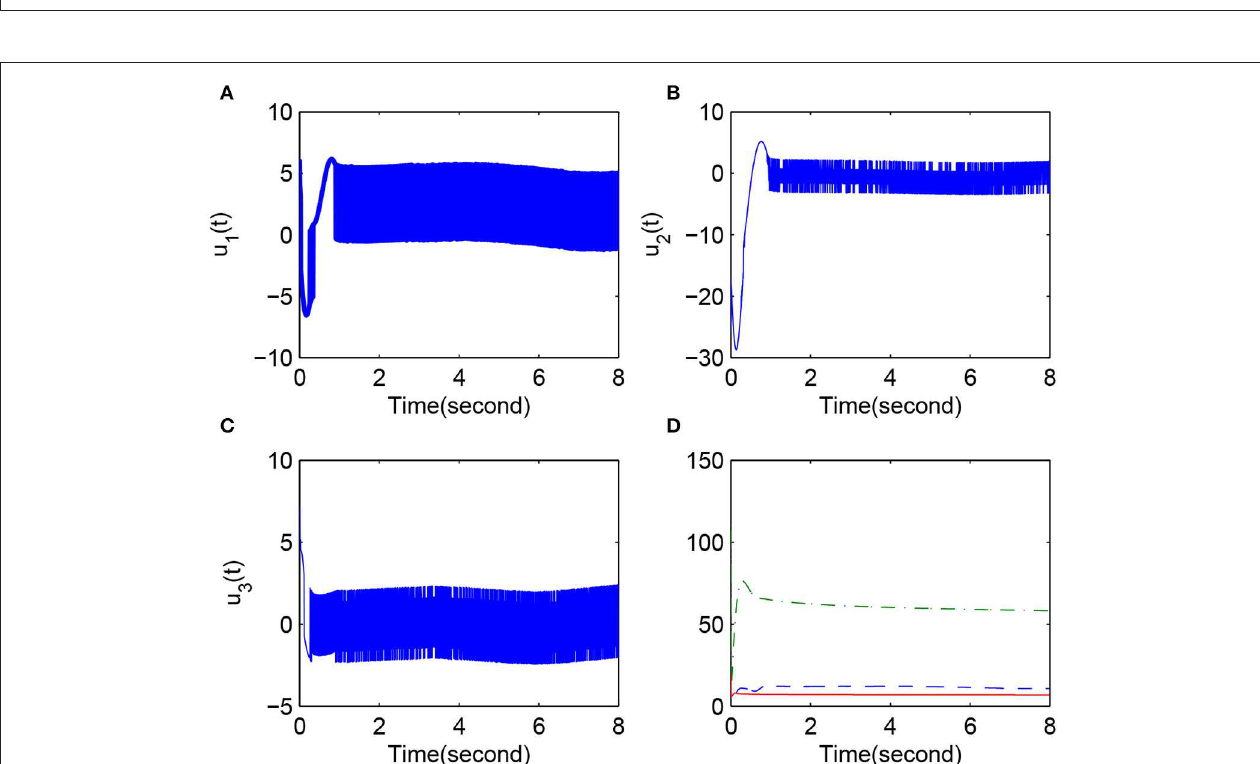
FIGURE 4 | Control variables and fuzzy logic system parameters of Case